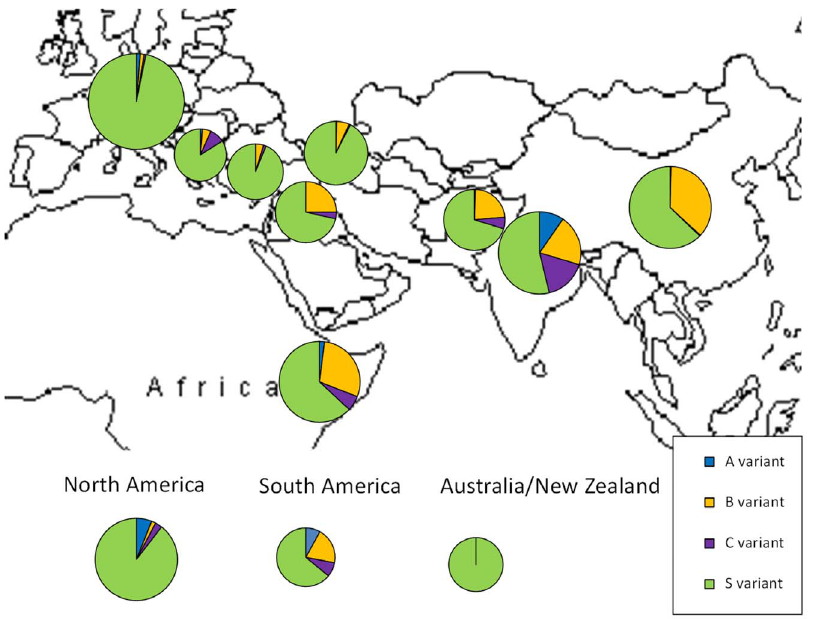
Figure 2. Geographical distribution of four eIF4E alleles expressed as percentage of total. Comparison of allele frequencies in 13 geographical regions, as detailed in Table 2.